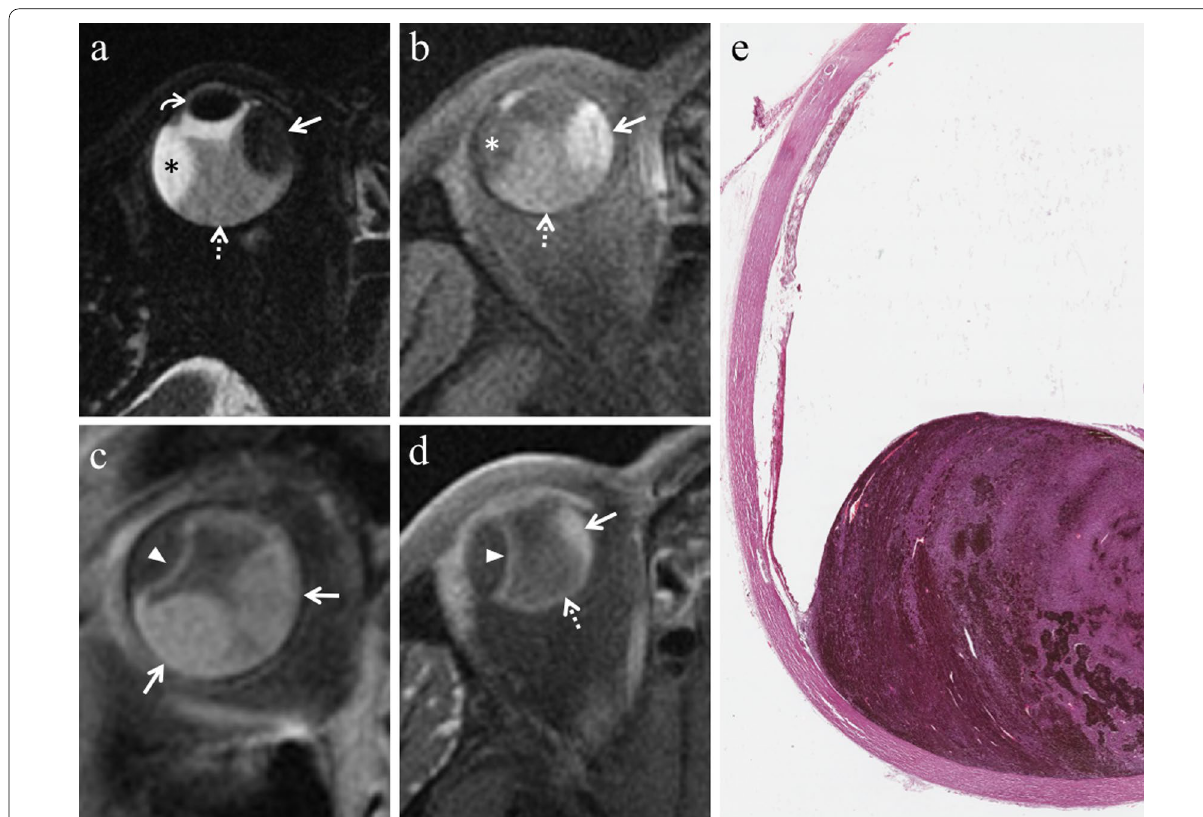
Fig. 18 A 70-year-old man with serous choroidal detachment and hemorrhagic retinal detachment due to a large lobulated pigmented choroidal melanoma along the medial and inferior aspect of the right eye. Axial ( a ) T2-weighted turbo spin-echo STIR and ( b ) fat-suppressed T1-weighted images, ( c ) coronal and ( d ) axial contrast-enhanced fat-suppressed T1-weighted images. The intraocular mass along the medial and inferior aspect of the globe exhibits low signal intensity on T2-weighted image (white arrow in a), high signal intensity on T1-weighted image (white arrow in b ) and mild enhancement after contrast agent administration (white arrows in c and d ). Along the supero-lateral aspect of the eyeball, the localized serous choroidal detachment, with its well-defined lentiform shape, is hyperintense on T2-weighted (black asterisk in a ) and hypointense on T1-weighted images (white asterisk in b ); the detached choroid is easily appreciable after contrast agent administration (white arrowheads in c and d ) because of its enhancement. The coexisting hemorrhagic retinal detachment demonstrates low signal intensity on T2-weighted image (white dotted arrow in a ), high signal intensity on T1-weighted image (white dotted arrow in b ) and does not enhance after contrast agent administration (white dotted arrow in d ). The lens is displaced anteriorly (white curved arrow in a ). e Histological examination: low magnification showing a pigmented uveal melanoma (below) and the coexisting choroidal detachment (on the left) (H&E, original magnification ×